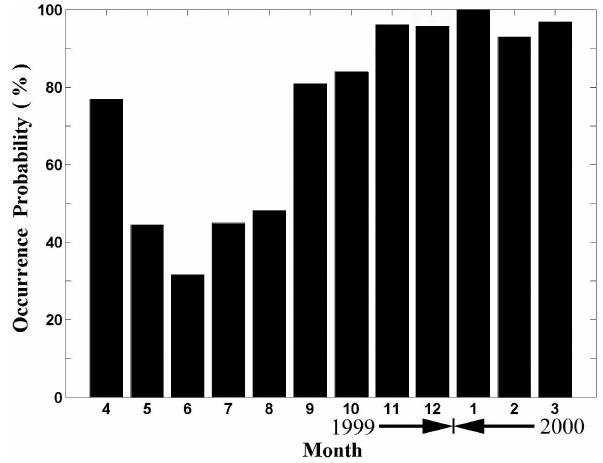
Fig. 4. Seasonal variation in the occurrence probability of ESF during April 1999–March 2000. The highest value (100%) of the occurrence probability appears in January, while the lowest value (30%) is at